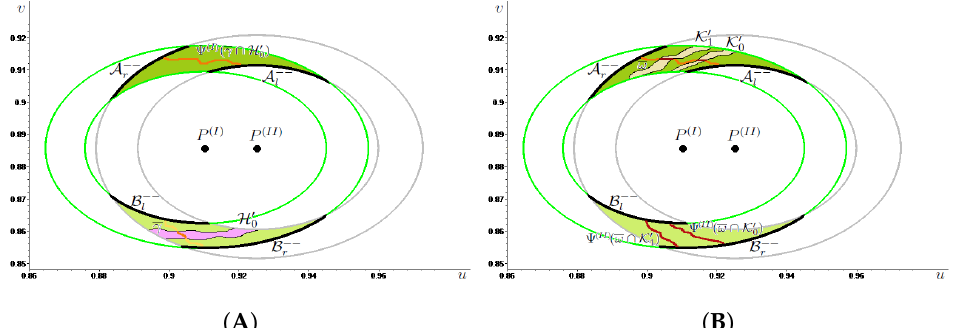
Figure A2. For the sets A and B , introduced in Figure A1, we now orientate them in a different manner by suitably choosing the left and the right sides, we illustrate in ( A ) the stretching relation (A5) with m ( I ) = 1 and in ( B ) the condition (A6) with m ( II ) =